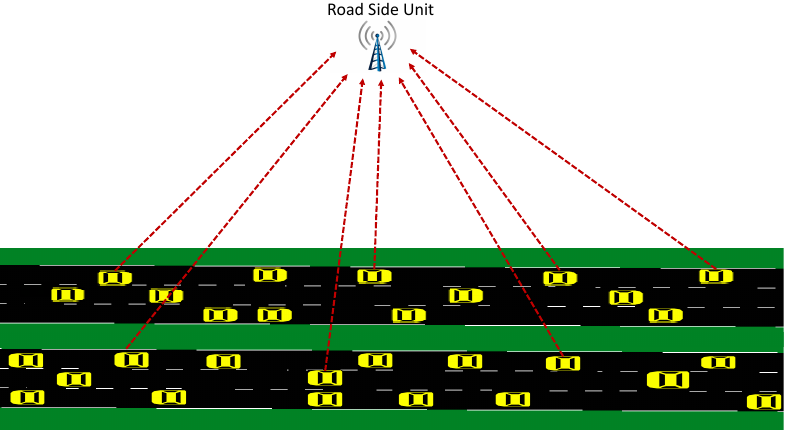
Figure 1. Traffic model for the nominal case where all vehicles broadcast messages and RSU collects these